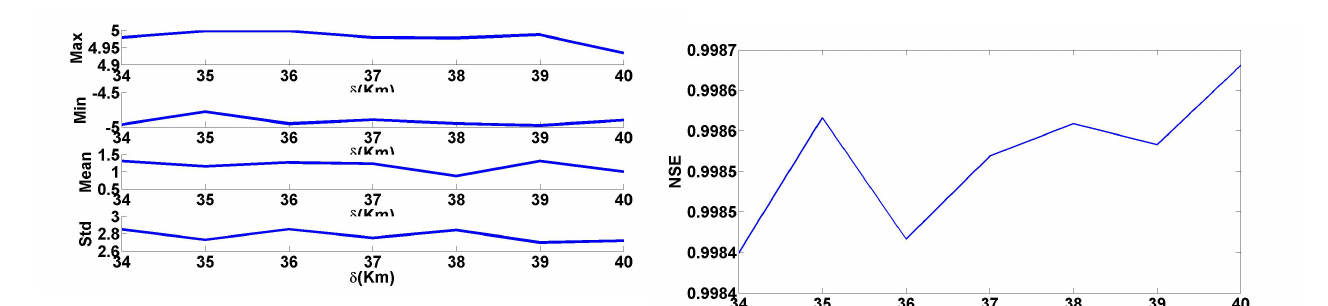
Fig. 3. Statistical properties (maximum, minimum, mean, and std) of the differences between SMLS approximated values and those from shipborne gravimetry, as a function of δ , SWF weight function